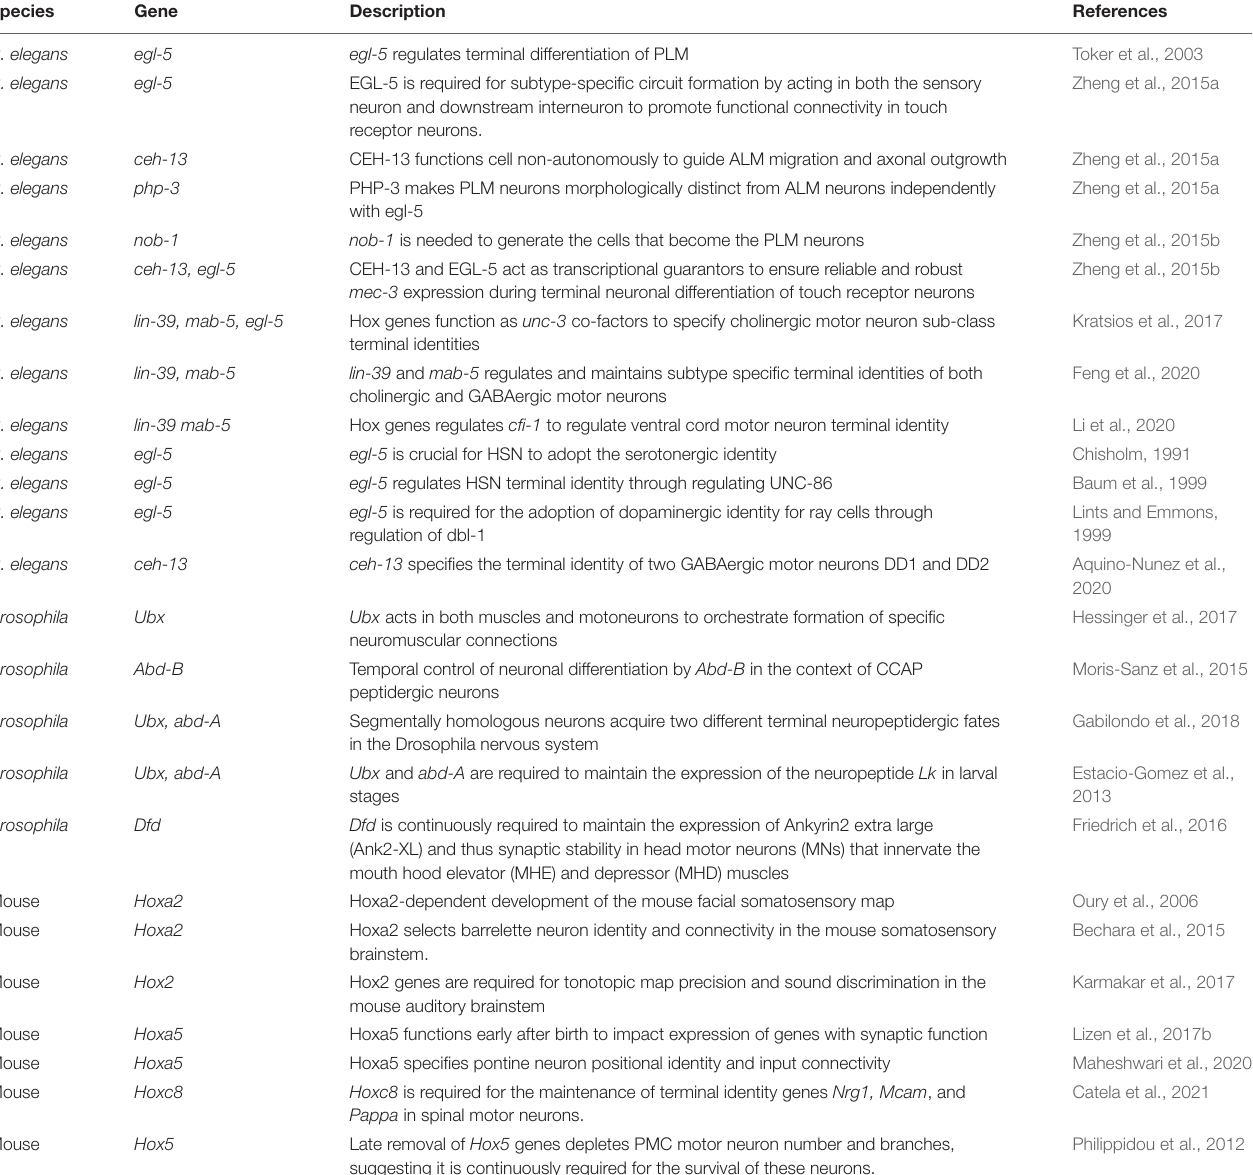
TABLE 1 | Hox gene studies focused on late steps of nervous system development. Species Gene